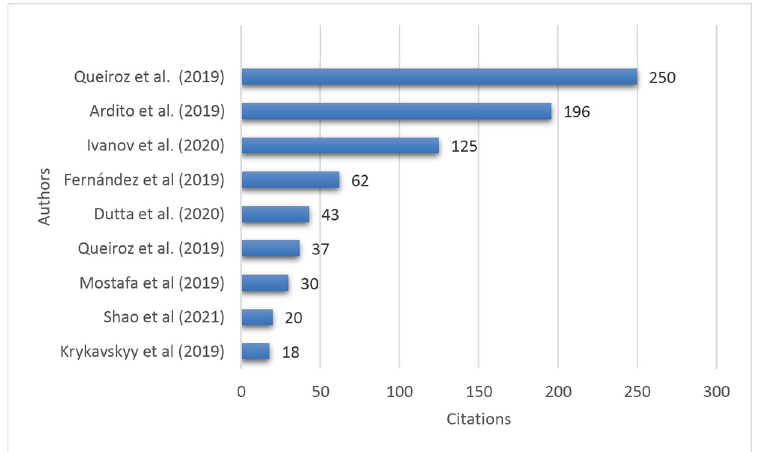
Figure 8. Top cited publications.